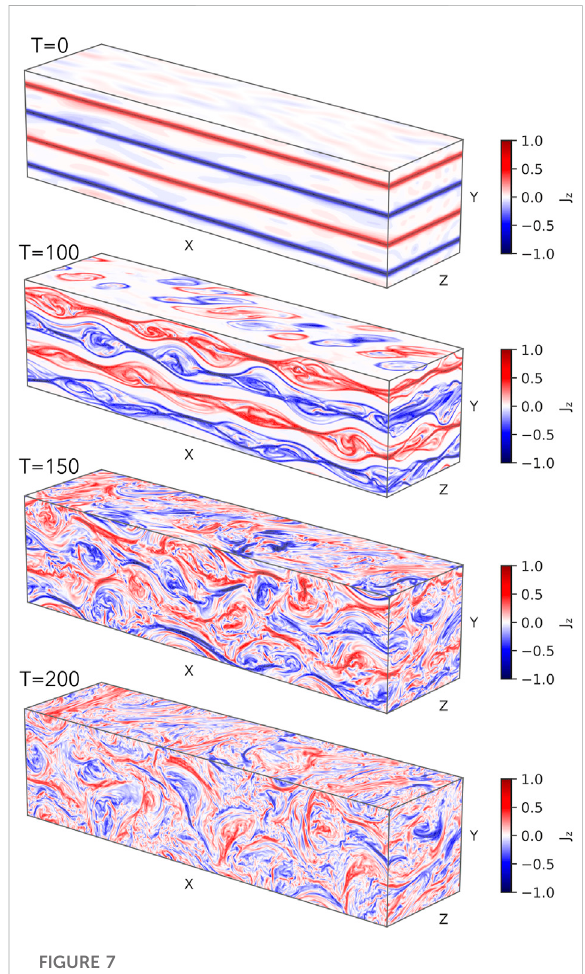
FIGURE 7 Time evolution ( t = 0, 100, 150, 200) of the current density J z in the 3D